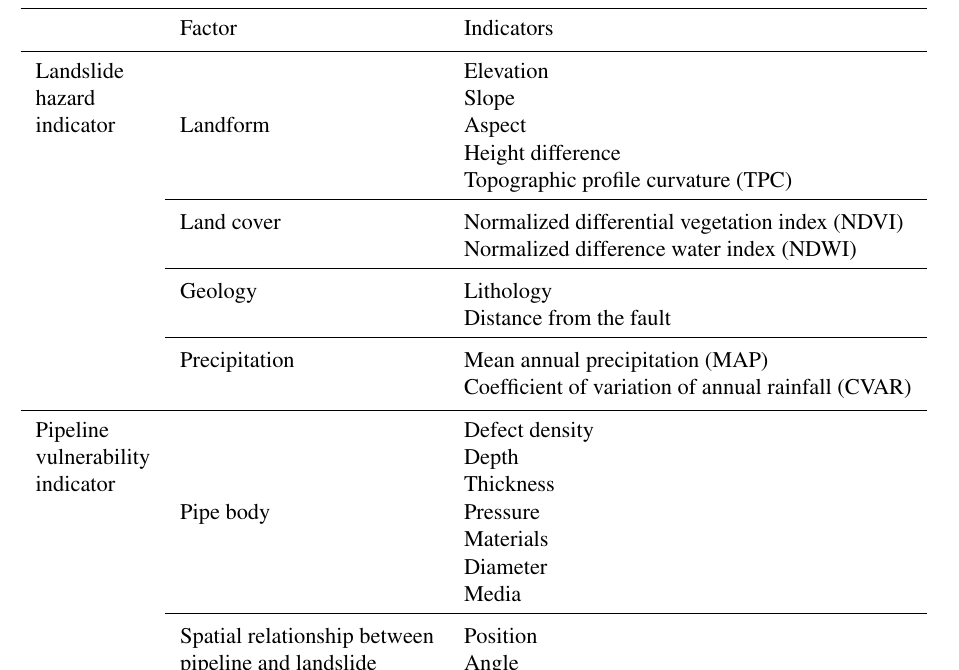
Figure 2. All slope units (a) and pipeline sections (b) in the study area. Table 1. Indicators of landslide susceptibility assessment and pipeline vulnerability